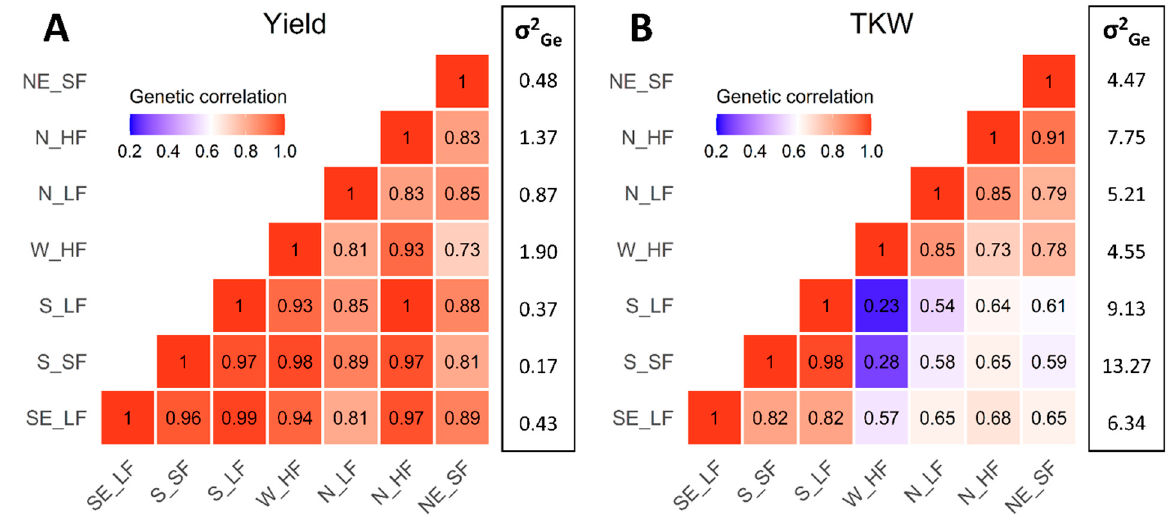
Figure 4. Heatmap of genetic correlations between environments estimated using linear mixed model for ( A ) yield and ( B ) thousand kernel weight. For each trait, the genetic variance estimates 𝜎 (cid:3008)(cid:3032)(cid:2870) of each environment are indicated in the column at the right of the heatmap.